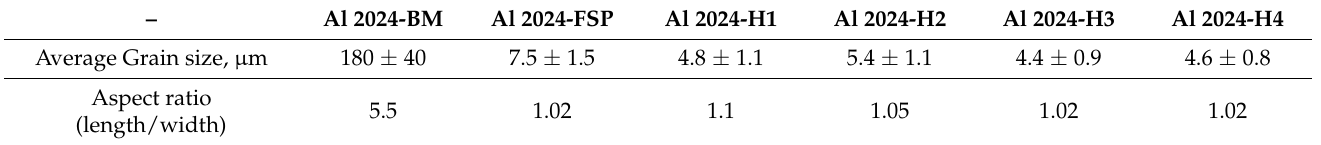
Table 5. The average grain size of the as-received alloy, after FSP, and manufactured surface nanocomposites. – Aspect